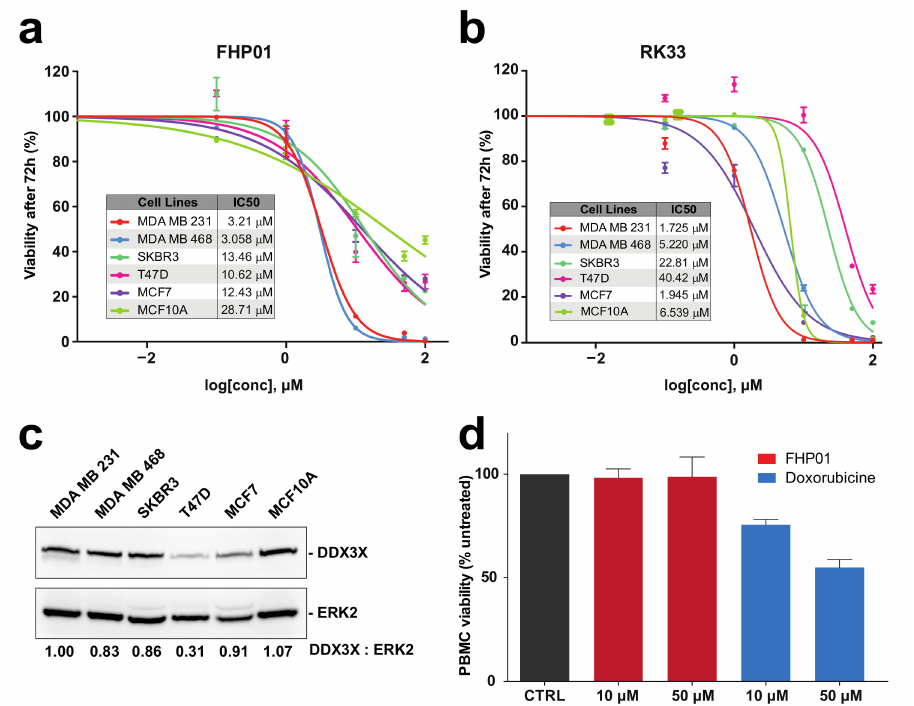
Figure 2. Cytotoxicity evaluation in different human breast-derived cell lines. ( a ) IC 50 evaluation, after 72 h treatment of MDA MB 231, MDA MB 468, SKBR3, T47D, MCF7 breast cancer cells and control MCF-10A immortalized cells, with the FHP01 compound, at different concentrations (0, 0.1, 1, 10, 50, 100 µ M), obtained by cell counting through a Z2 coulter counter. The results shown are averages of triplicate samples from a typical experiment; ( b ) Same as in panel ( a ) but using the RK33 molecule; ( c ) DDX3X expression in different breast cancer cell lines, evaluated by western blot analysis. Anti-ERK2 immunoblot was used to normalize total lysates protein levels. Representative images from 3 independent experiments are shown ( n = 3). Intensitometric analysis of DDX3X, normalized by ERK2 protein levels, was performed using NIH ImageJ; ( d ) Cell viability of PBMCs was measured after 72 h treatment with indicated concentrations of FHP01 and Doxorubicin (used as a positive